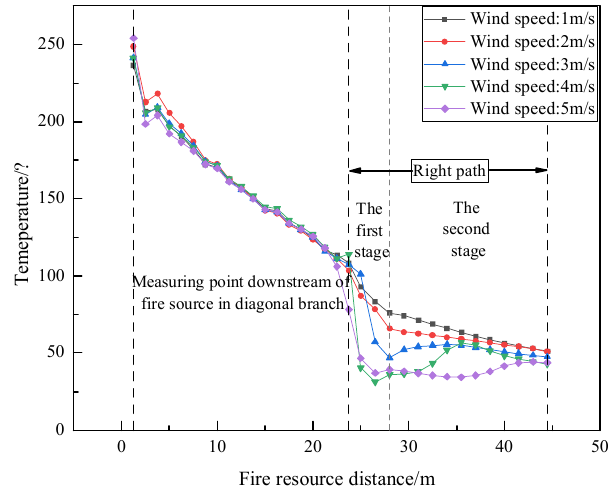
Figure 9. Temperature attenuation diagram of upstream measuring point of fire source.